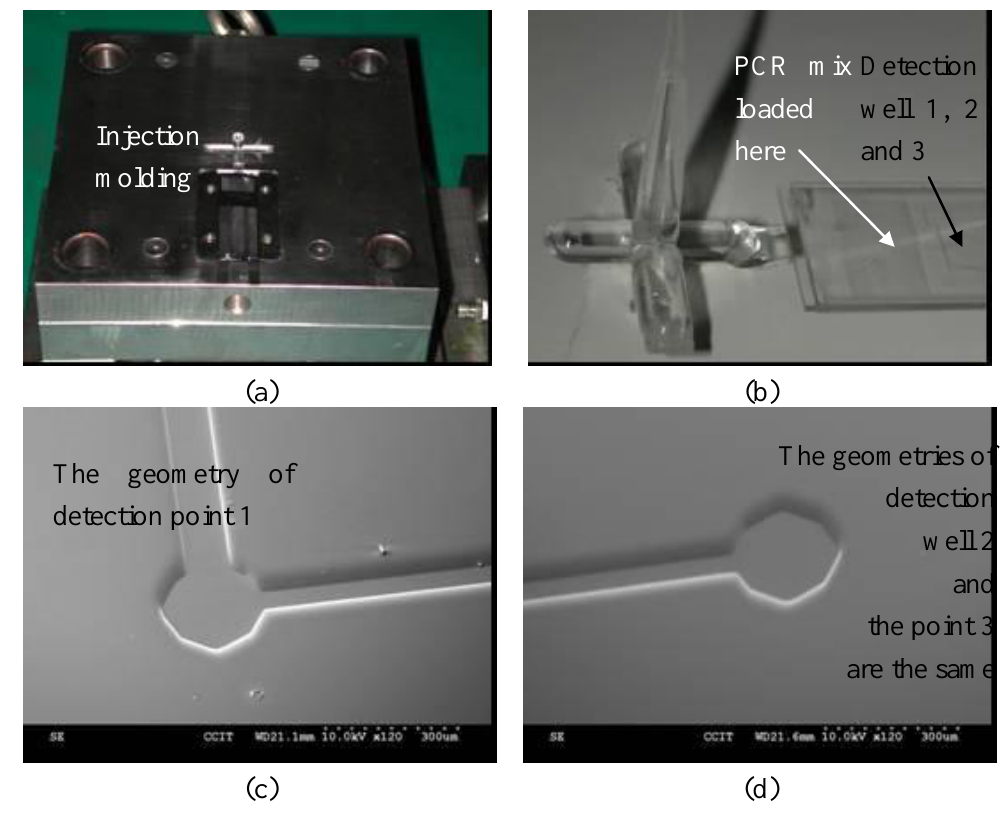
Figure 4. SEM pictures of detection well